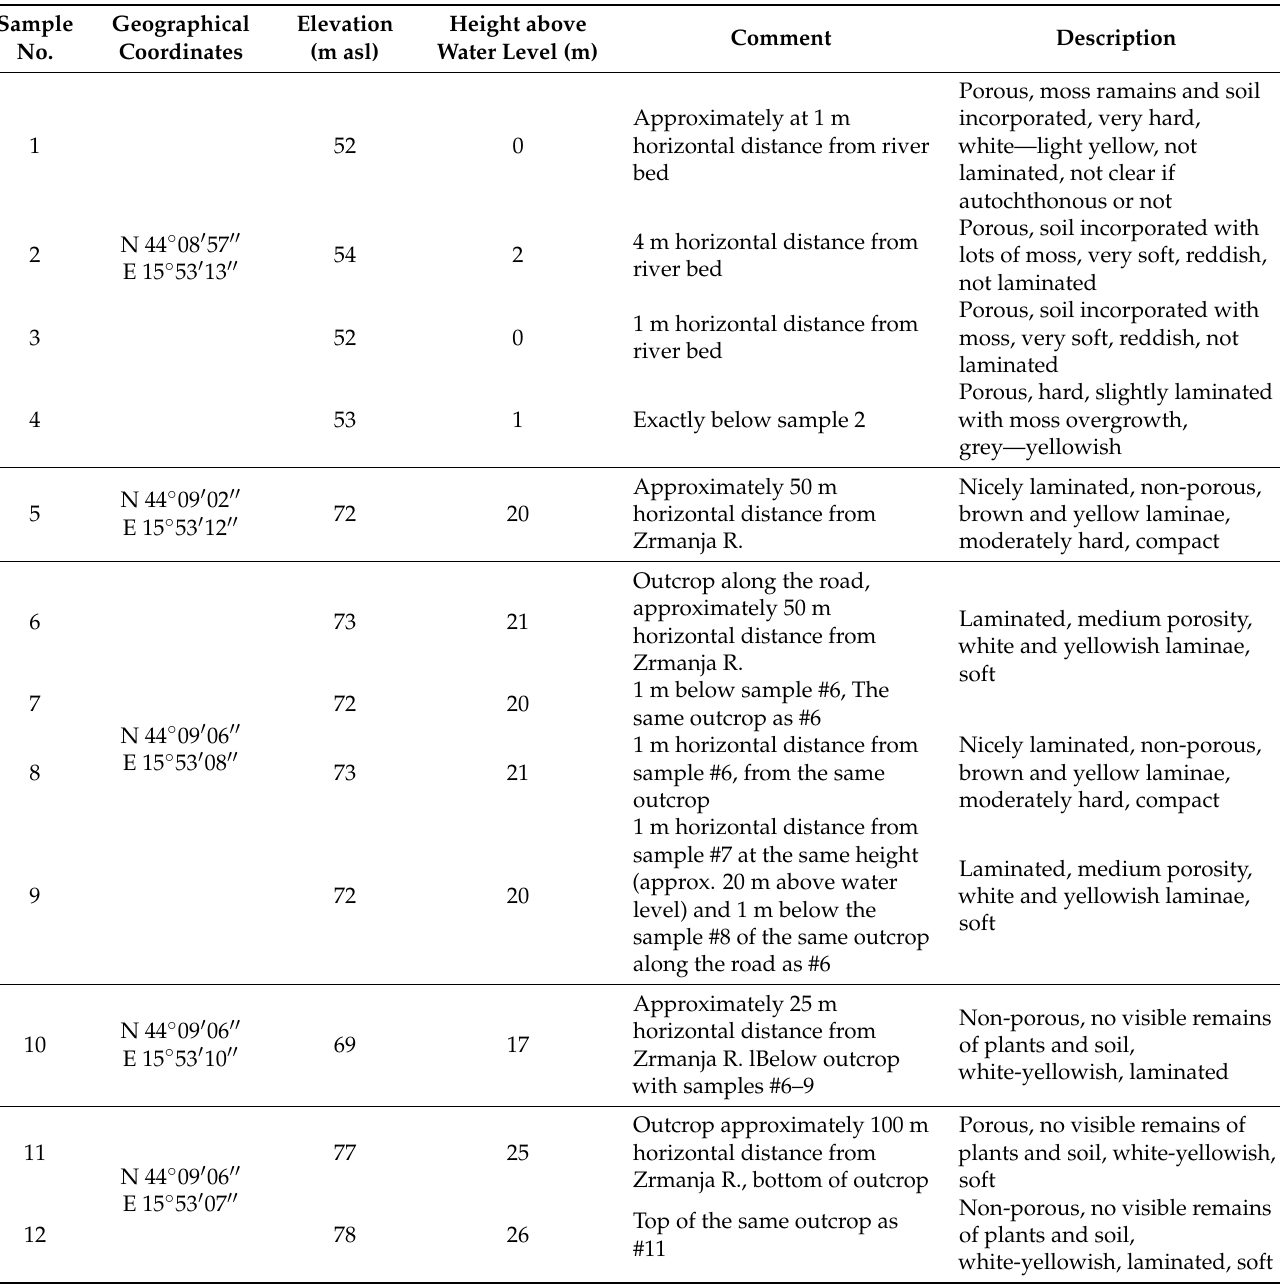
Table 1. Geographical coordinates, approximate elevations, and height above the water level of samples at the Sanaderi location (Figure 1). Comments regarding microlocations and sample description are also given.